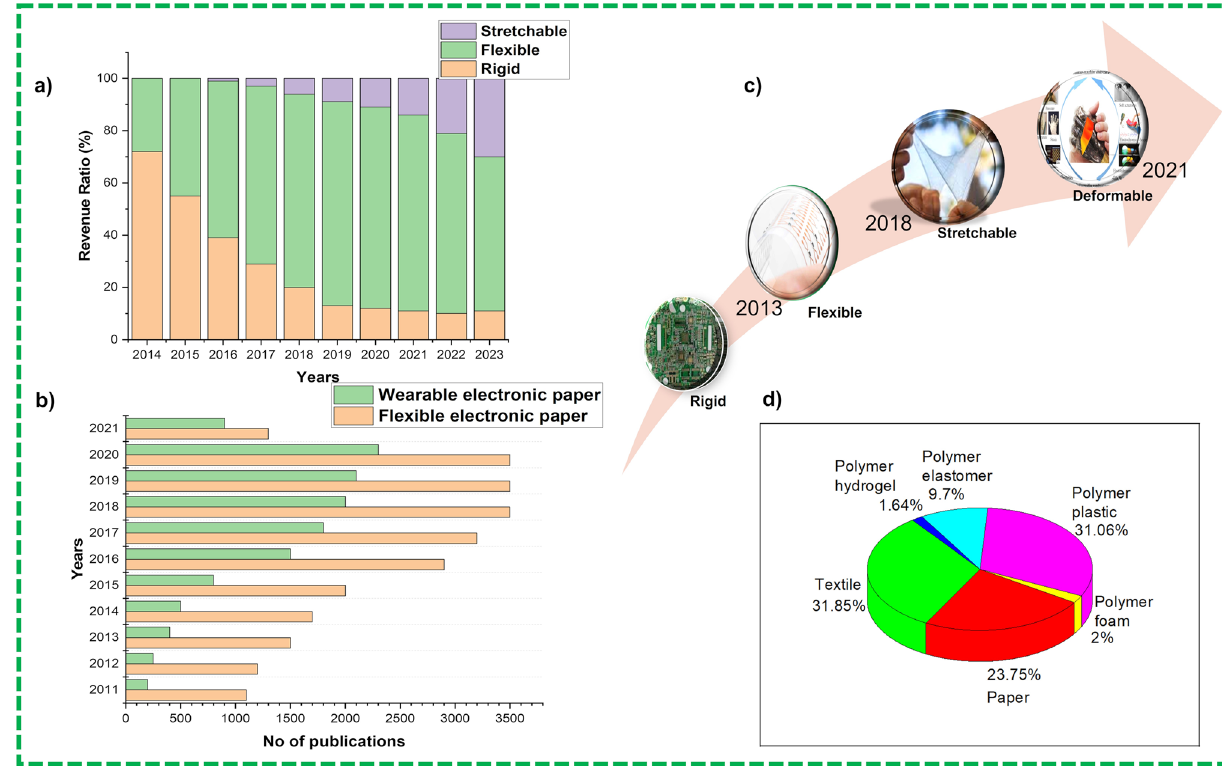
Fig. 1 a world Revenue ratio of flexible electronics [6]. b Number of publications on flexible and wearable electronic devices during peri 2011– 2021 period. c Evolution of fabrication of flexible electronics. d Comparative allocation of number of publications for different polymer and flexible substrates during 2011–2021 period and data are also indexed in Web of Science in December